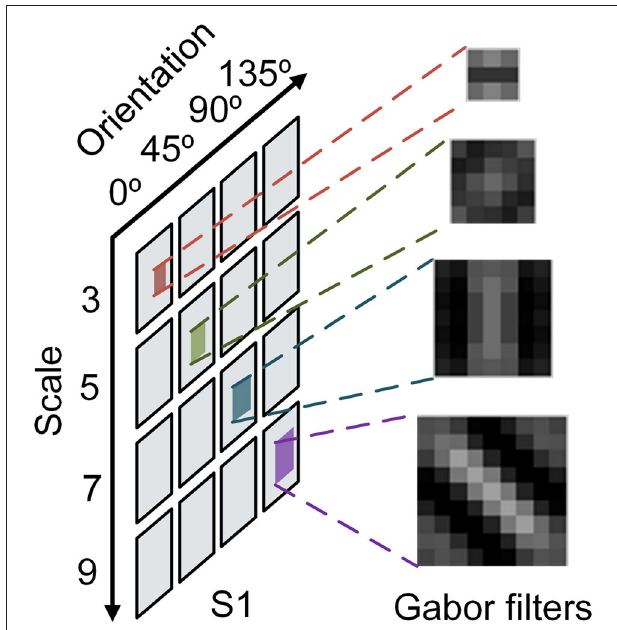
FIGURE 2 | Convolution kernel in different scales and